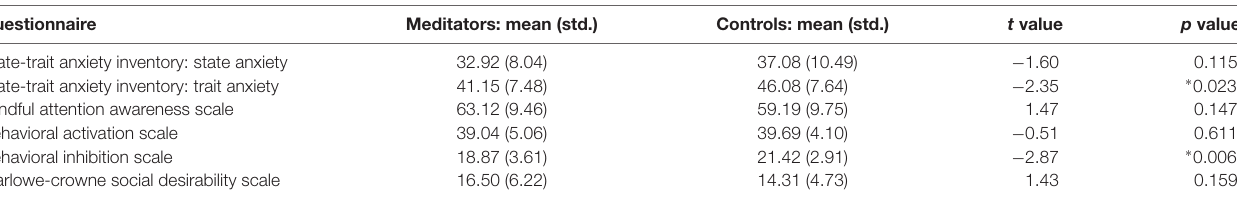
TABLE 1 | Independent t -tests between meditator and control groups on different self-report